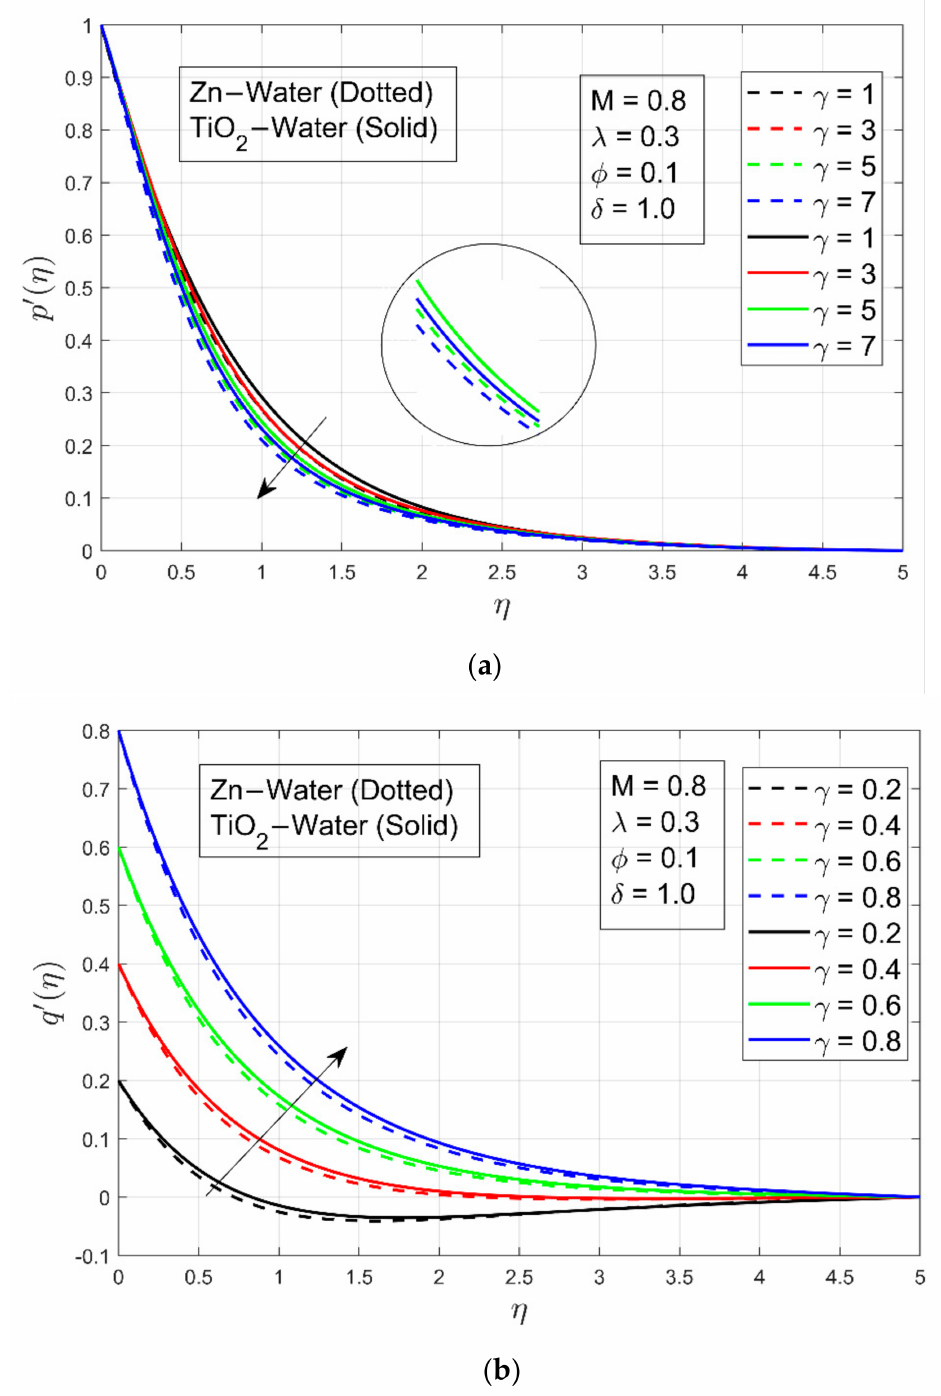
Figure 4. ( a ) The influence of γ on p (cid:48) ( η ) , and ( b ) the influence of γ on q (cid:48) ( η ) . A distinction in temperature profile, r ( η ) , against the magnetic parameter, M , is shown in Figure 5a. We can determine from Figure 5a that the rise in magnetic constraint, M